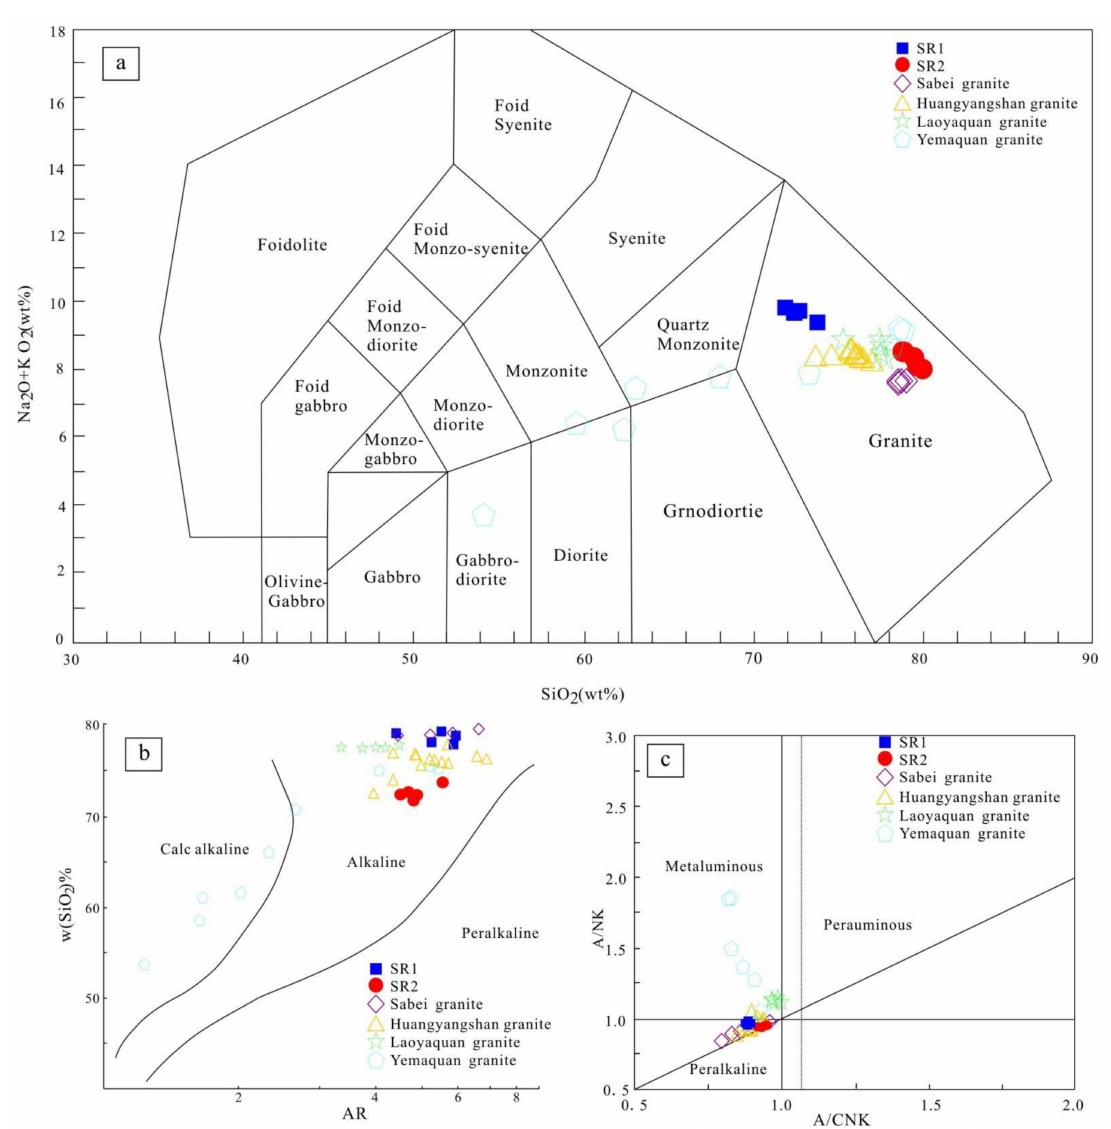
Figure 4. Geochemical characteristics of the medium-fine-grained granites and granite porphyry in the Sayashk Sn deposit. ( a ) SiO 2 vs. (Na 2 O + K 2 O) diagram. ( b ) AR vs. SiO 2 diagram. ( c ) A/CNK vs. A/NK diagram. Sabei granite after [30], Huangyangshan granite after [58], Laoyaquan granite after [9], Yemaquan granite after [59].